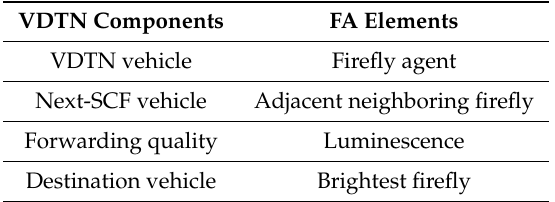
Table 1. Vehicular Delay Tolerant Network (VDTN)/Firefly Algorithm (FA)